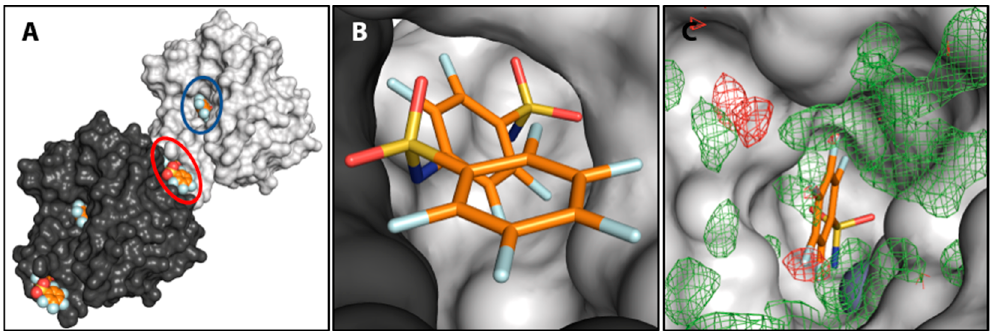
Figure 8. ( A ) Surface representation of two hCAII crystal mates that enclose dimer 18 between them. The binding site of 18 and the active site including a model of 14 are indicated by red and blue ellipses, respectively. ( B ) Close-up of the binding site of 18 between two hCAII crystal mates. ( C ) Residual mFo-DFc density at 3 σ (green) and − 3 σ (red) above the active site with the modeled monomer 14 (for difference electron density allowing to model 14 , see Figure 2L).